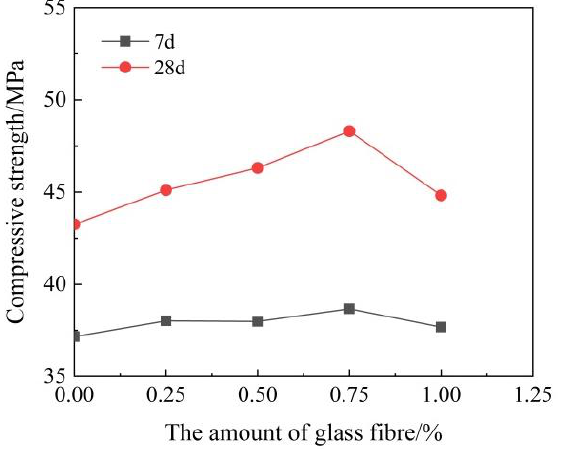
Figure 3. Relationship between the amount of alkali-resistant glass fiber and the static compressive strength of SCM.